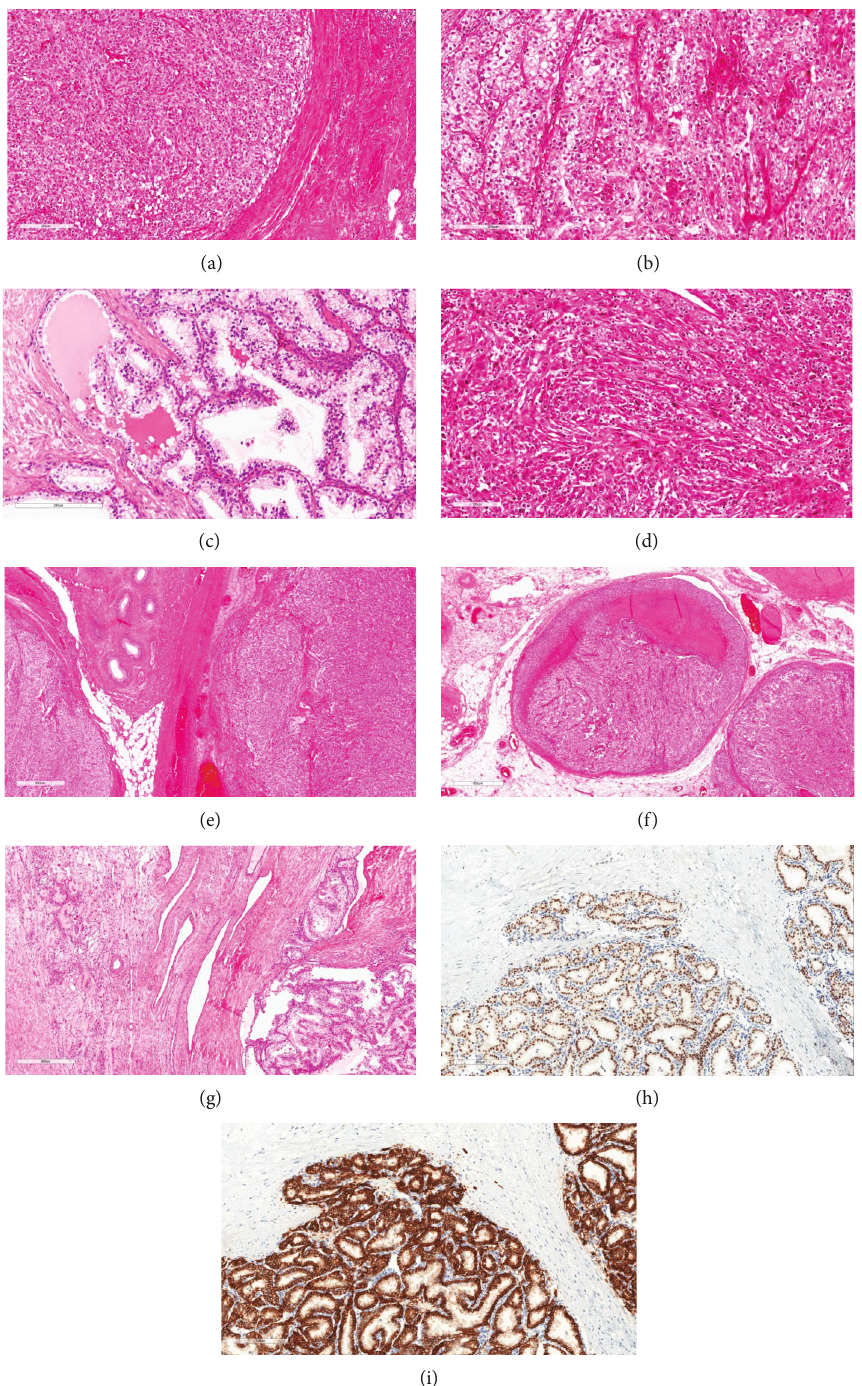
Figure 1: Microscopic examination of metastatic renal cell carcinoma in the testis; (a) the broad pushing border at the edge of the tumor; (b) the metastatic tumors showed mixed patterns of tubules, cysts, or well-vascularized nests; (c) low-grade area with cystic change, lined by clear cells and proteinaceous eosinophilic fl uid; (d) small component of sarcomatoid dedi ff erentiation (WHO/ISUP grade 4); (e) tumor abutted the epididymis; (f) tumor present in the vessels in the hilar soft tissue; (g) residual testicular parenchyma showed decreased spermatogenesis, tubular atrophy, and fi brosis, with only interstitial Leydig cells remaining; (h) metastatic renal cell carcinoma was positive for PAX8; (i) metastatic renal cell carcinoma was positive for